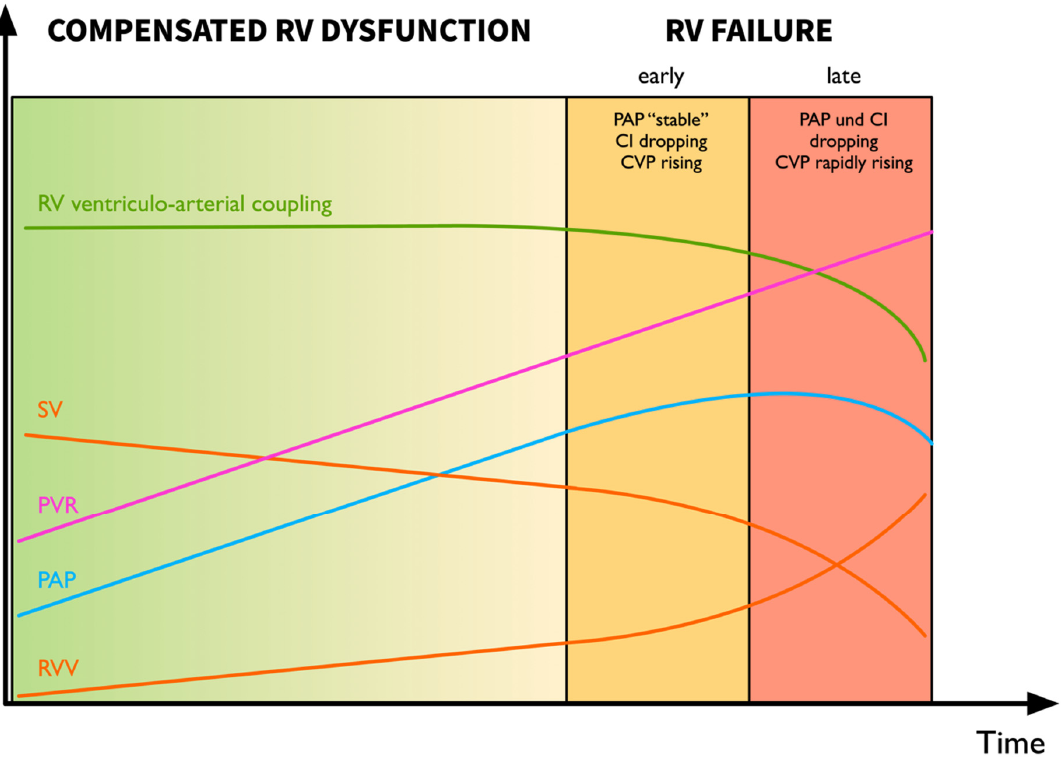
Figure 1. The progression from right ventricular (RV) dysfunction to failure is a continuum marked by progressive RV dilation and increases in heart rate to maintain cardiac index. When the compensatory mechanisms are exhausted, ventriculo-arterial uncoupling occurs with a drop in cardiac index and pulmonary pressures as well as a rise in central venous pressure, late markers of RV failure and imminent cardiovascular demise. Abbreviations: CI, cardiac index; CVP, central venous pressure; PAP, pulmonary artery pressure; PVR, pulmonary vascular resistance; RV, right ventricular; RVV, right ventricular volume; SV, stroke volume. Modified from Haddad et al. [8] Vonk Noordegraaf et al. [11] and Wanner PM & Filipovic M. (Der rechte Ventrikel—das Wichtigste für den Intensivmediziner. In: Eckart, Forst, Briegel, eds.: Intensivmedizin. Kompendium und Repetitorium zur interdisziplinären Weiter- und Fortbildung. ecomed Verlagsgesellschaft AG & Co., Landsberg. 2018) [12].